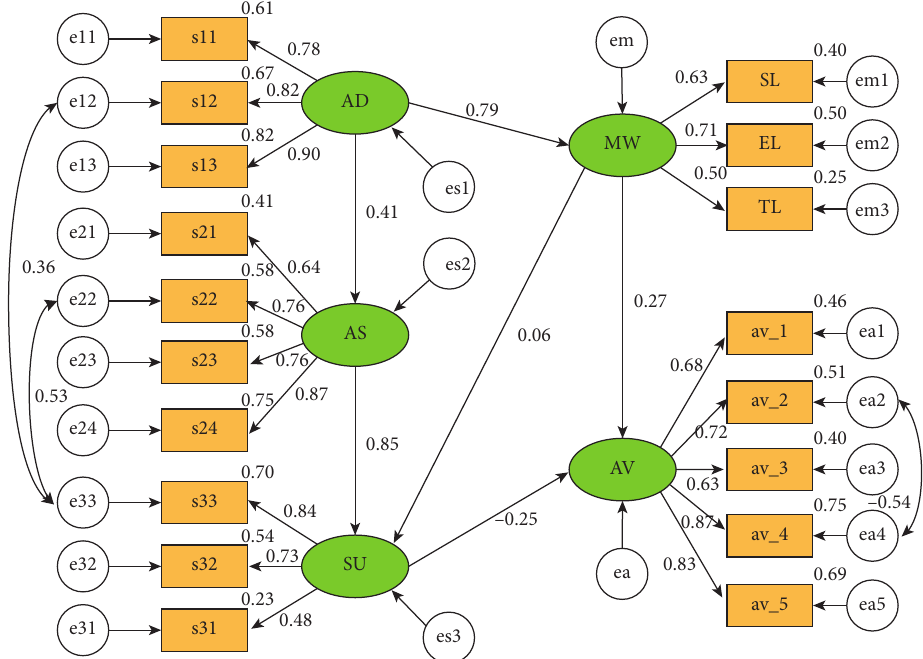
Figure 5: Estimated results with standardized estimates. Note: AD � attention demand; AS � attention supply; SU � situation under- standing; MW � mental workload; AV � aggressive violations.